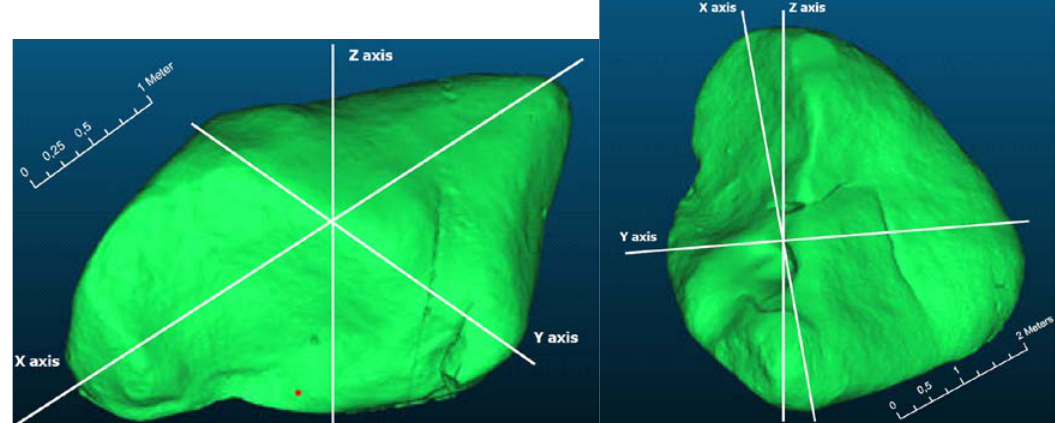
Figure 9. Boulders with marked cross sections in X, Y and Z axes (Boulder No.1 – left, boulder No.2 – right).